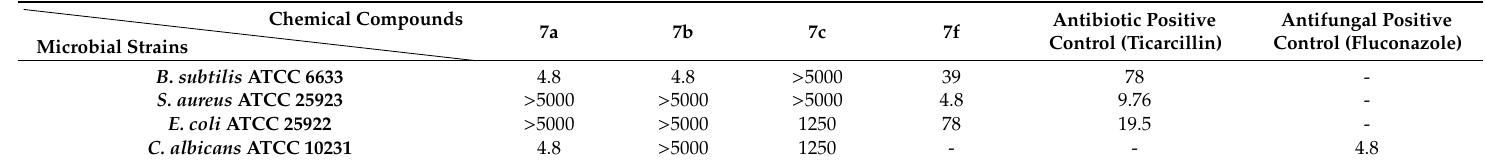
Table 5. The results of the quantitative assay of the antimicrobial activity of the compounds selected by the qualitative screening and the corresponding MIC value ( µ g /